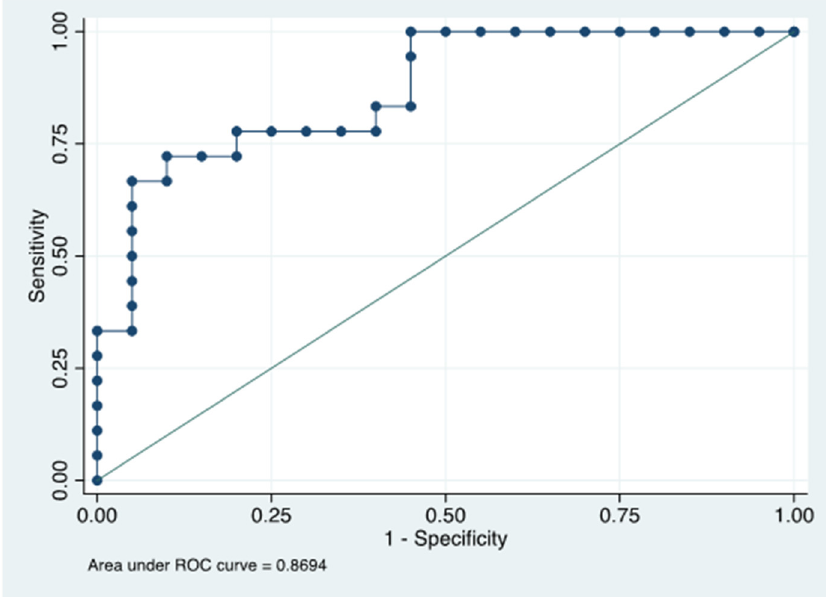
Figure 2. Receiver operating characteristic (ROC) curves for MMP-9 to evaluate its biomarker’s ability. The line drawn from the 0.00 to the 1.00 point corresponds to the reference diagonal.